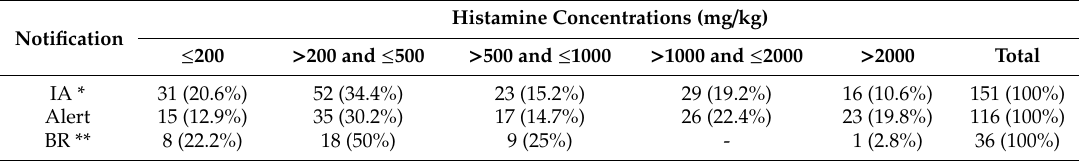
Legend: * information for attention; ** border